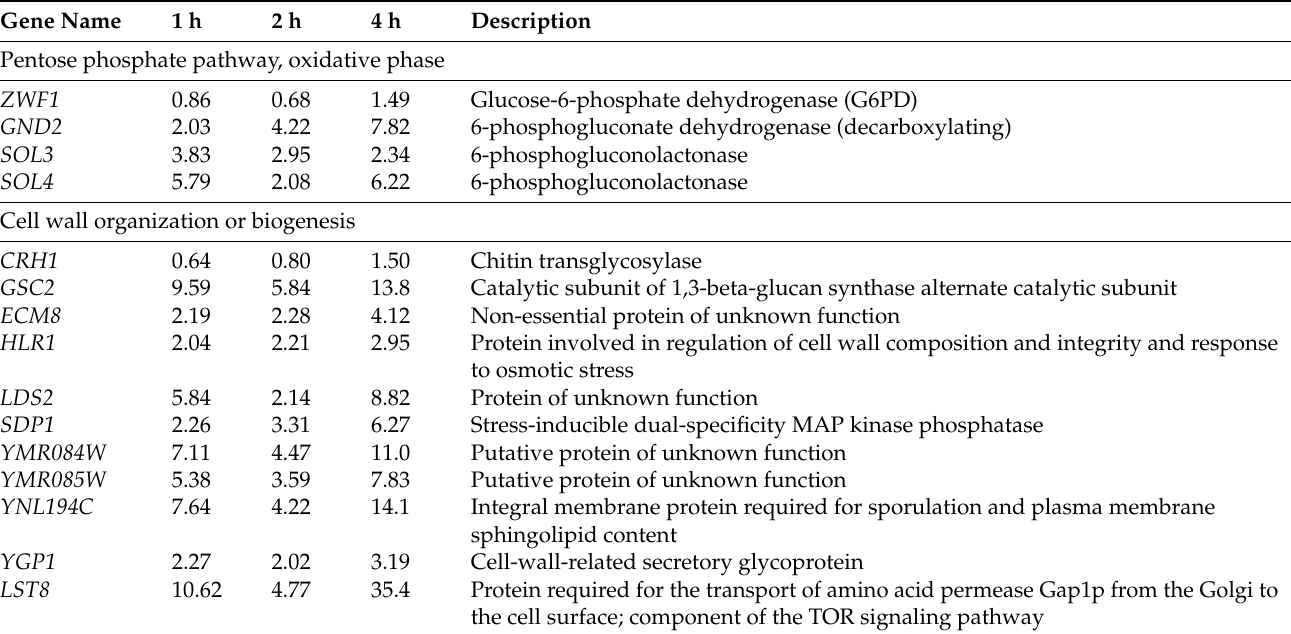
Table 4. Major categories were identified by GO analysis and their induction multipliers for each treatment